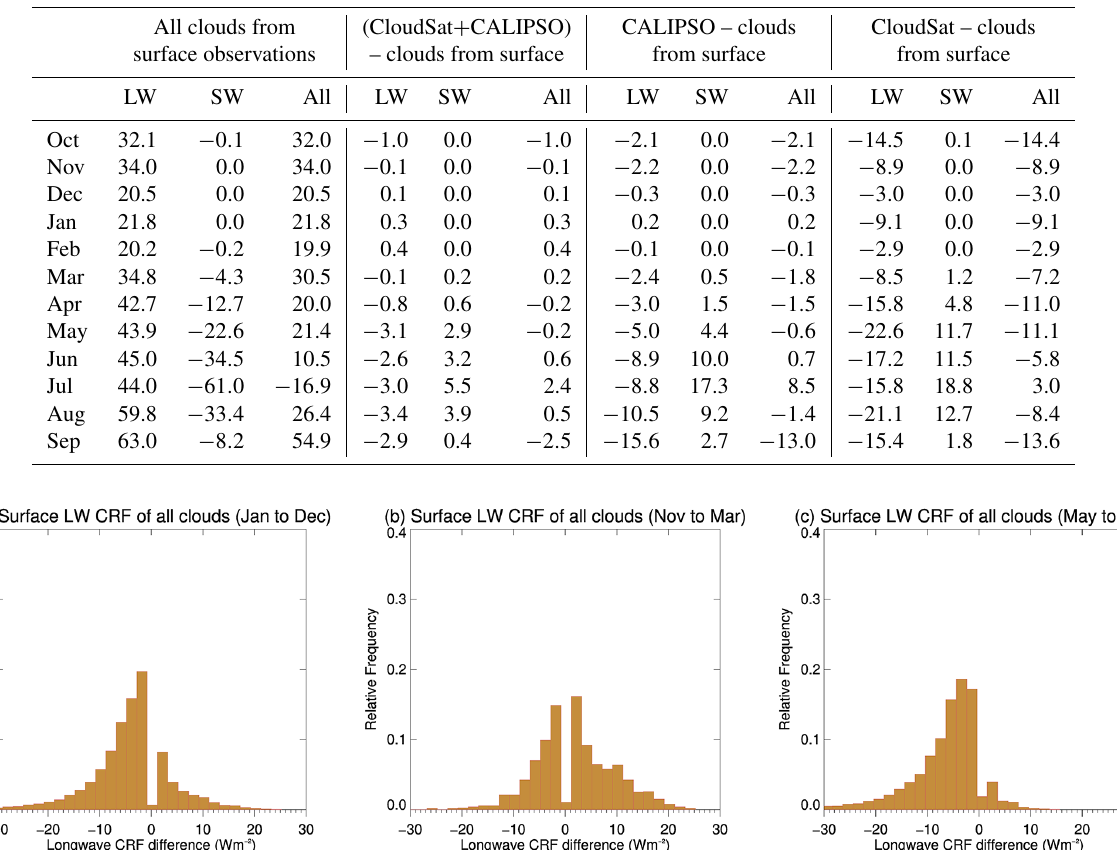
Figure 10. Histogram of longwave cloud radiative forcing at the surface using clouds identified by combined CloudSat and CALIPSO and using clouds from surface observations during the SHEBA experiment for (a) January to December, (b) November to March, and (c) May to September. Ratios of cases with absolute differences less than 1Wm − 2 to all cases are 69.1%, 81.5%, and 59.7%, for panels (a) , (b) and (c) , while being excluded from the